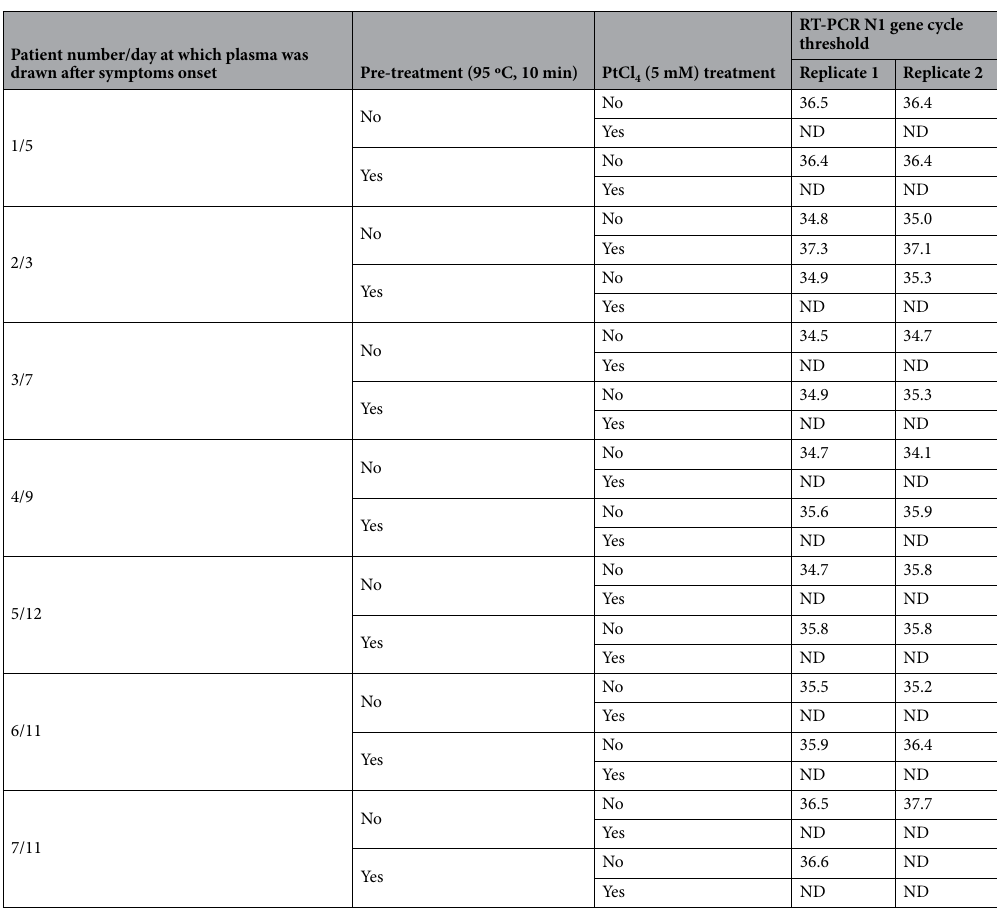
Patient number/day at which plasma was drawn after symptoms onset Pre-treatment (95 ºC, 10 min) PtCl 4 (5 mM) treatment